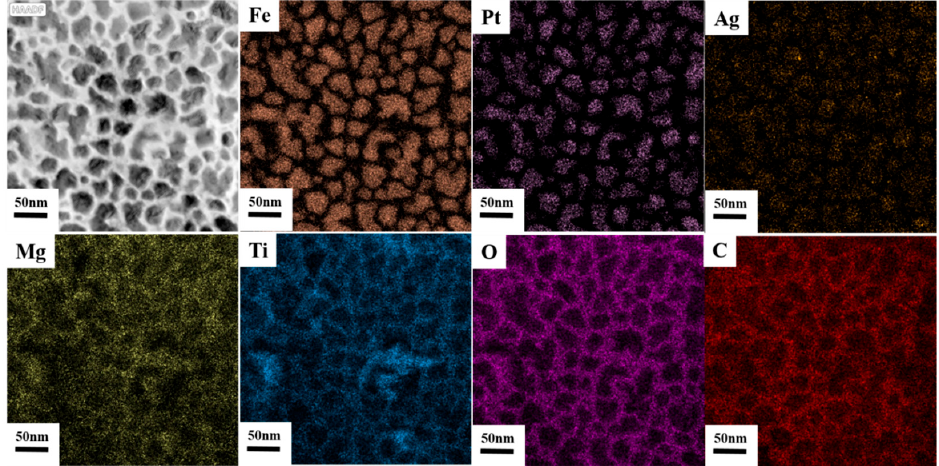
Figure 11. High angle angular dark field (HAADF) image and EDX mapping of Fe, Pt, Ag, Mg, Ti, O, C elements.